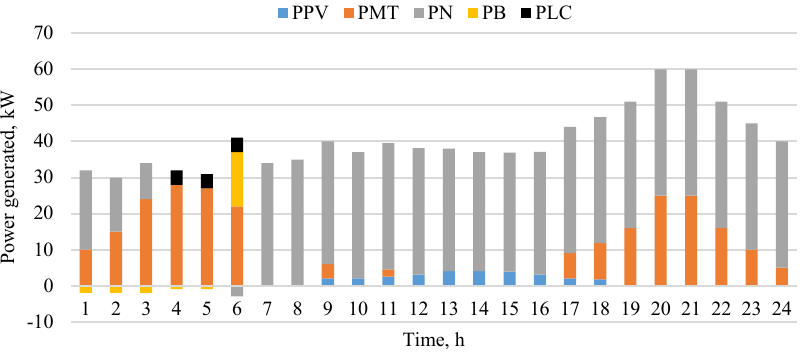
Fig. 6. Output power of each components and network in scenario